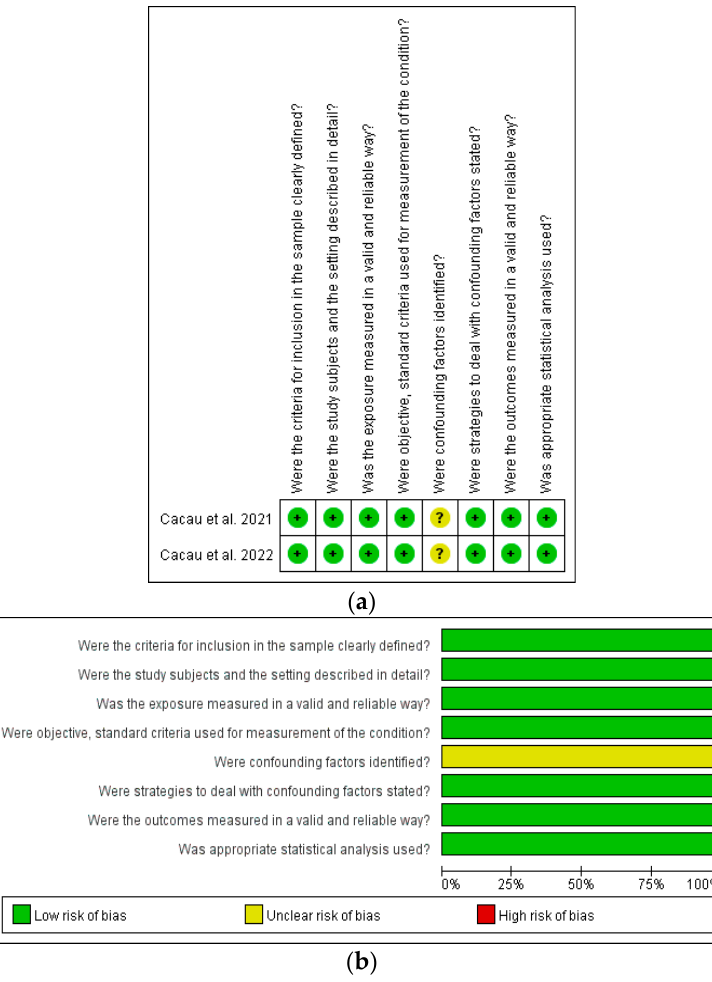
Figure 3. ( a , b ): Quality assessment of cross-sectional studies [23,24], according to the Joanna Briggs Institute reviewers’ manual.